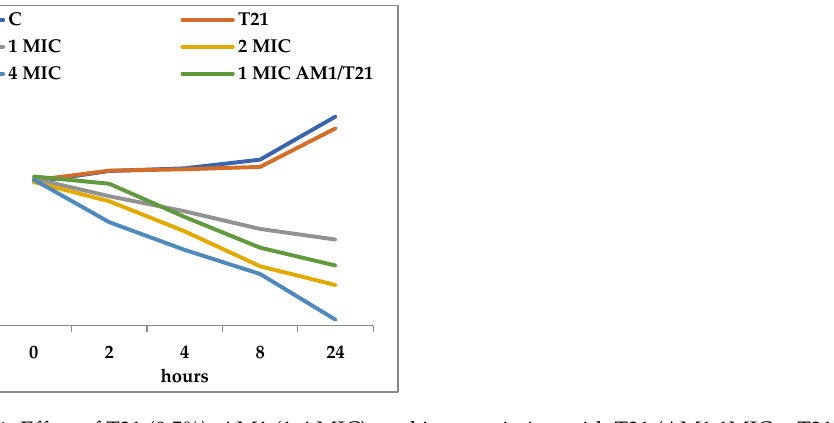
Figure 1. Effect of T21 (0.5%), AM1 (1-4 MIC), and its association with T21 (AM1 1MIC + T21) on the time-killing dynamics in S. aureus ATTC 33952.